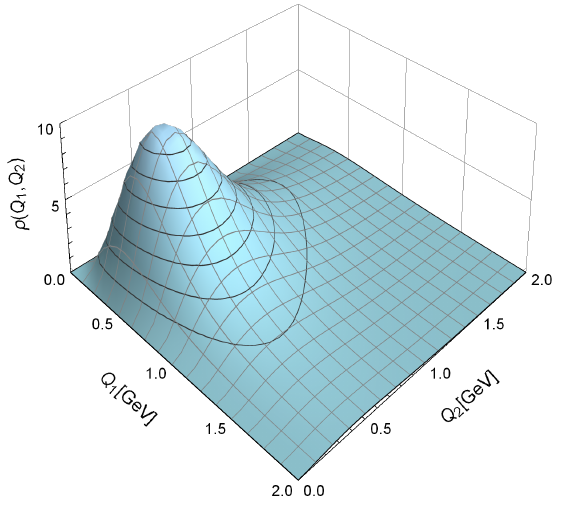
Figure 3. Behaviour of the density (12) in units 10 − 11 GeV − 2 , for the axial-vector meson f 1